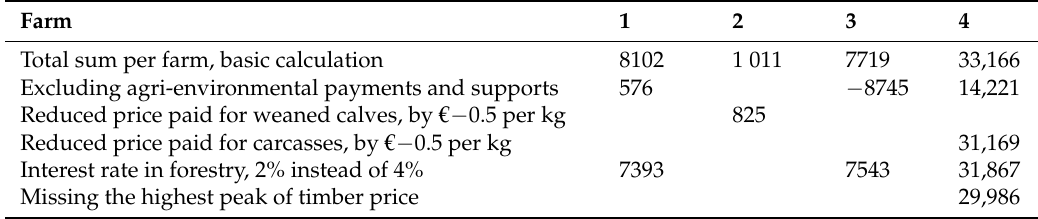
Table 4. Sensitivity analysis for profitability, € after tax per farm and year, when changing five variables relevant in creation of large coherent pastures from small scattered pastures in five Swedish cow-calf enterprises (Farms 1–4, Farm 5 not